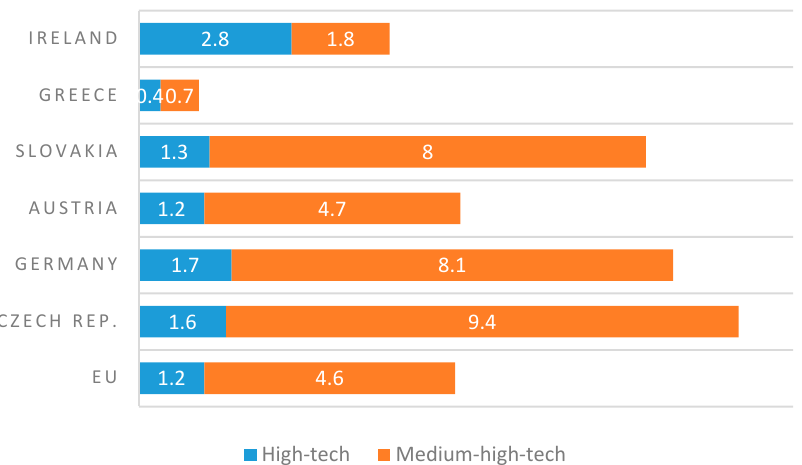
Figure 3. Employment in High-tech and Medium-high-tech sectors in 2015 in selected European Union (EU) countries.